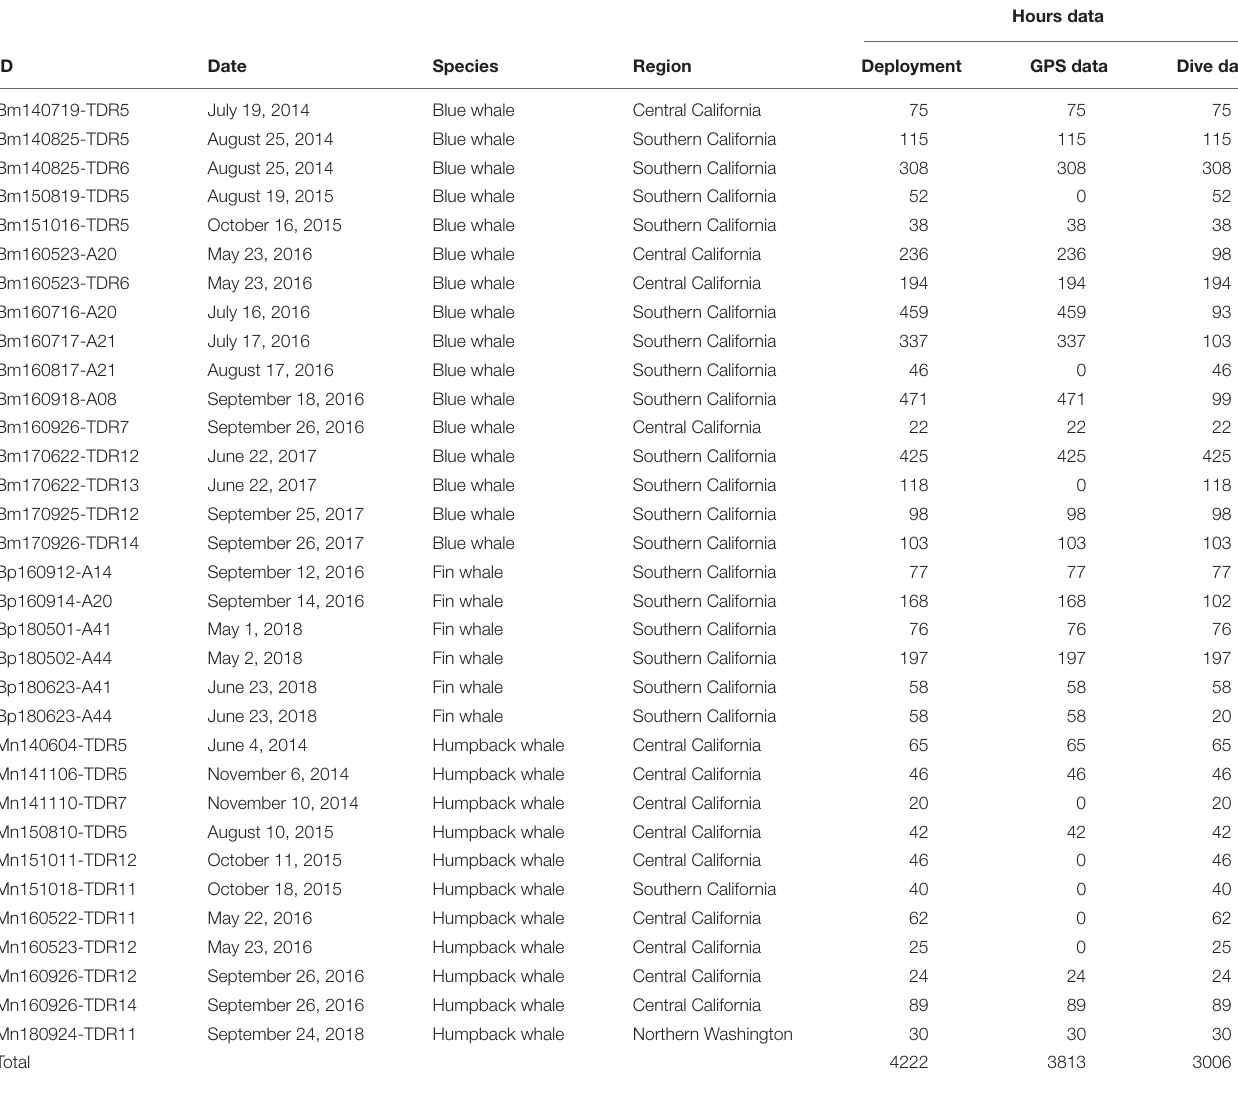
TABLE 1 | Summary of deployments used for this analysis by